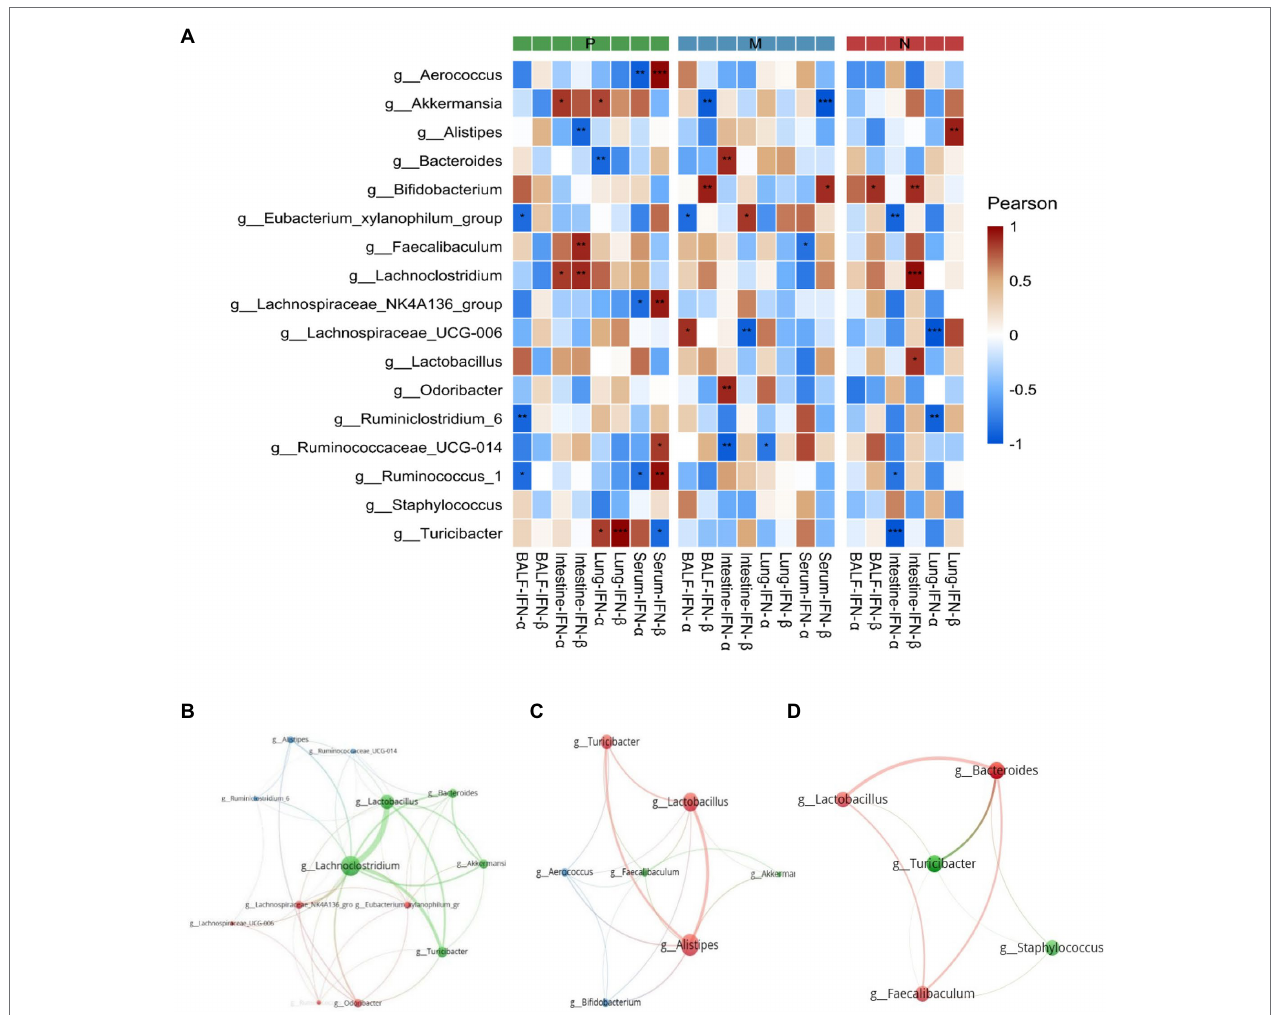
FIGURE 8 | The Pearson correlation between dominant bacterial genera and the transcription and expression of type I interferon (A) and the correlation between the dominant bacterial genera in groups P (B) , M (C) , and N (D) are shown in the correlation diagram. The P values were adjusted according to the Bonferroni and Hochberg procedures to determine the false discovery rate. Asterisks indicate a significant correlation between bacterial groups and type I interferon (* P < 0.05, ** P < 0.01, *** P < 0.001). P, challenged H9N2 cells after pretreatment with PBS; M, challenged H9N2 cells after pretreatment with L. plantarum 0111; N, pretreatment with